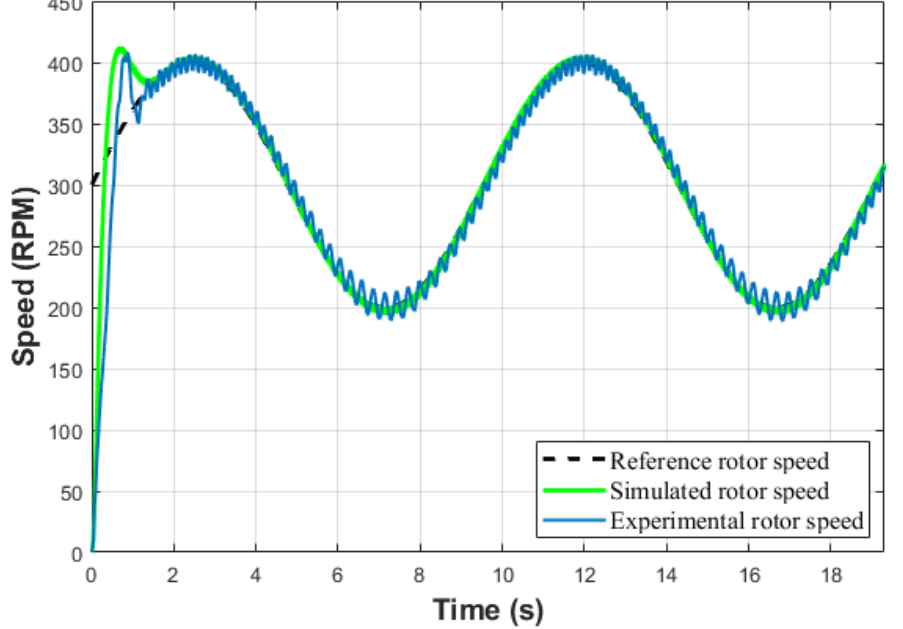
Figure 23. Behavior of the speed control loop with 0.1 Hz sinusoidal reference. Table 8. Speed controller